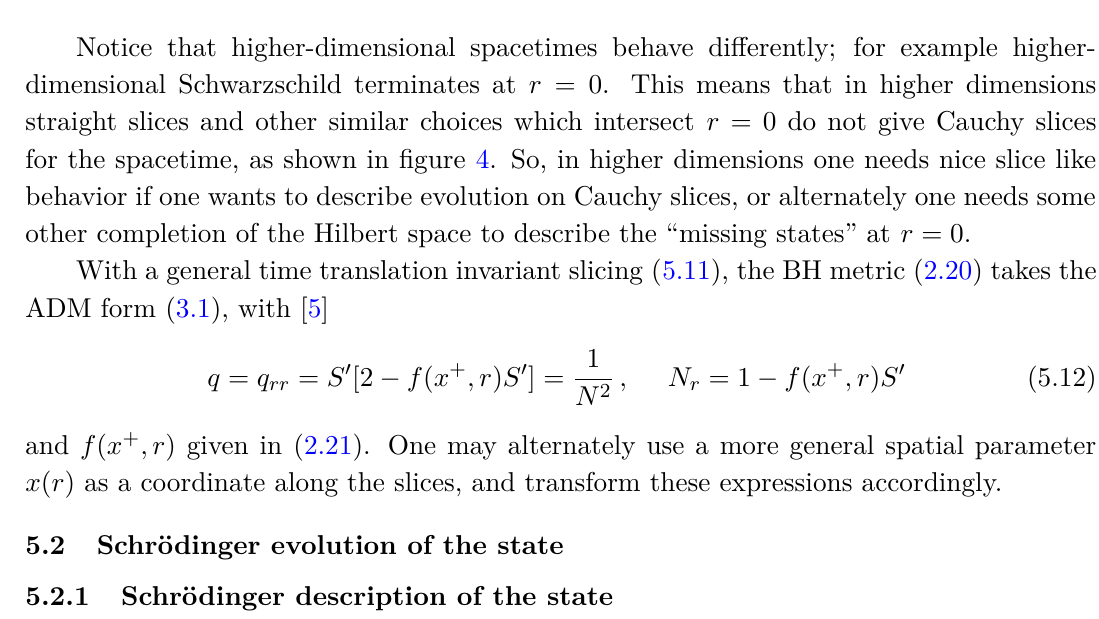
Figure 3 . A slicing of the 2d BH spacetime which in the post-formation region utilizes nice slices. These asymptote to the radius R n < R , shown in light green. However, in the pre-formation region these would not give Cauchy slices; Cauchy slices can be constructed by extending the slices differently into the early region, as shown in light